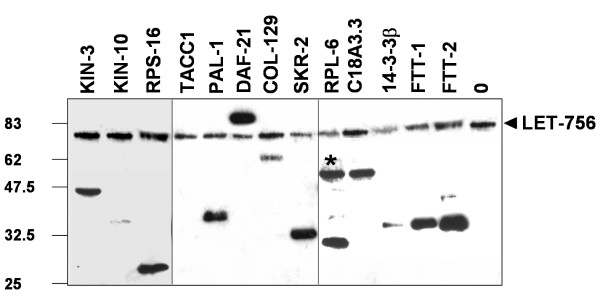
Co-immunoprecipitation of LET-756::GFP and HA-tagged protein partners Cos-1 cells were transfected with let-756::gfp alone (0) and with various HA-tagged constructs presumed or not (TACC1) to interact with LET-756. Twenty four hours later cell lysates were immunoprecipitated with anti-GFP antibodies. Western blots were first revealed with anti-HA antibodies and then with anti-GFP antibodies. An additional band, indicated with an asterisk, was consistently observed with HA- tagged RPL-6. A week and non- reproducible band can also be seen in the FTT-2 co-immunoprecipitation lane. None of these bands arose from possible complexes since 1) electrophoresis was performed in denaturating conditions and 2) antibody detection relied on the tag epitope and not on the endogenous protein.